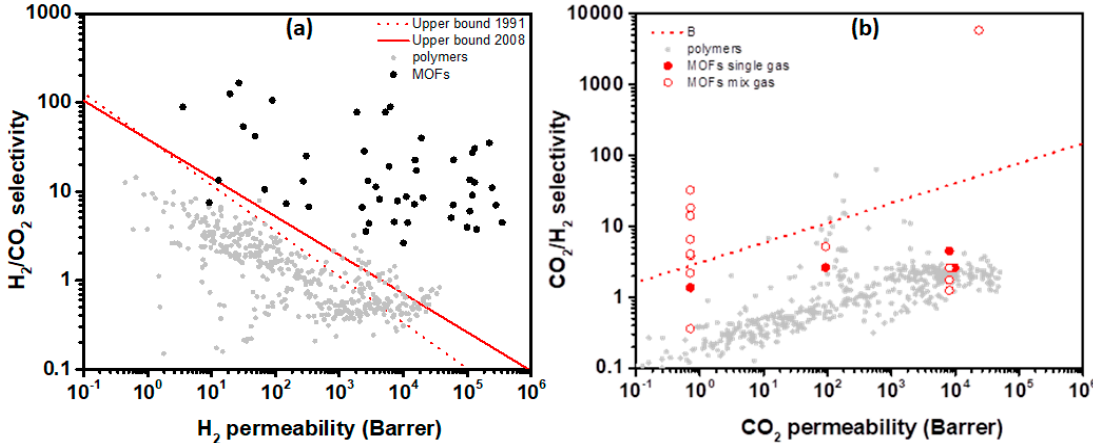
Figure 71. Comparison of permeation properties of MOFs to the performance of polymeric materials reported in the literature for membrane-based: ( a ) diffusion-driven H 2 /CO 2 separation ( b ) sorption-driven reverse selective CO 2 /H 2 separation. All the data points are listed in the supporting information (Tables S1 and S2).